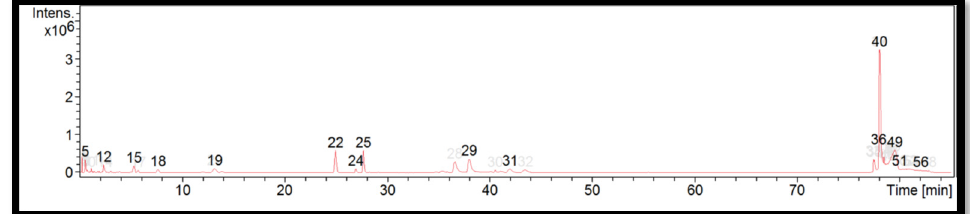
Figure 4. LC-MS/MS chromatogram of D. sublaevigata